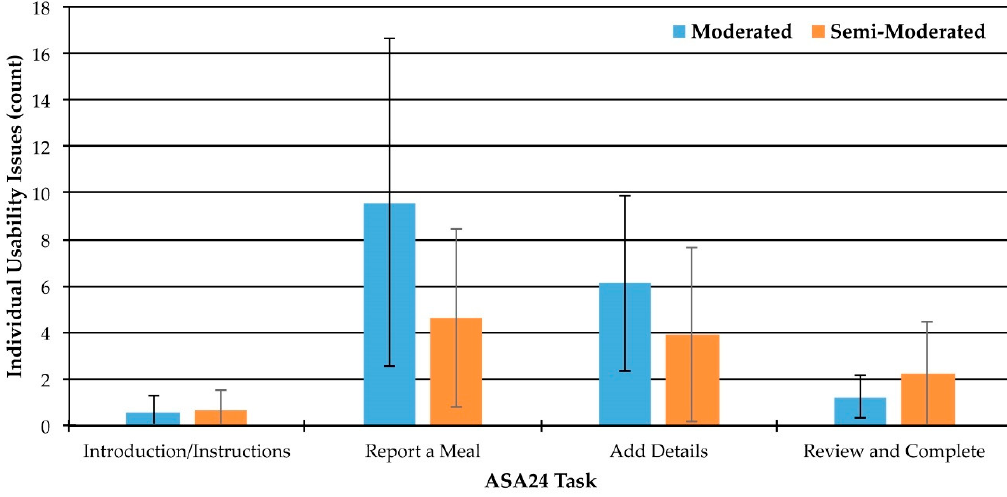
Figure 4. Average number of individual usability issues encountered by participants in the moderated ( n = 10) and semi-moderated ( n = 11) groups across all four tasks in the ASA24. Error bars represent one standard deviation above and below the